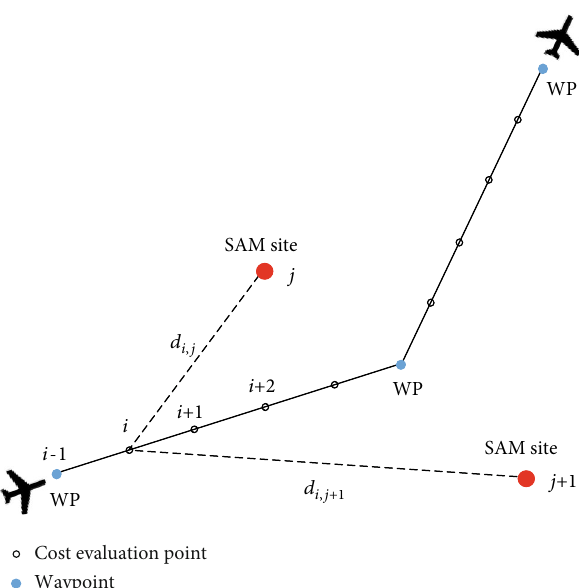
Figure 4: Cost calculation at cost evaluation points along a